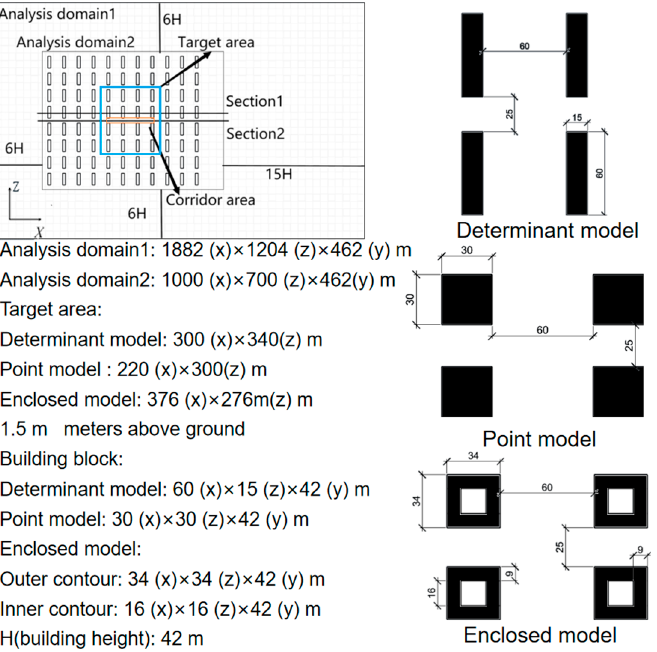
Figure 3. Architectural layout diagram.